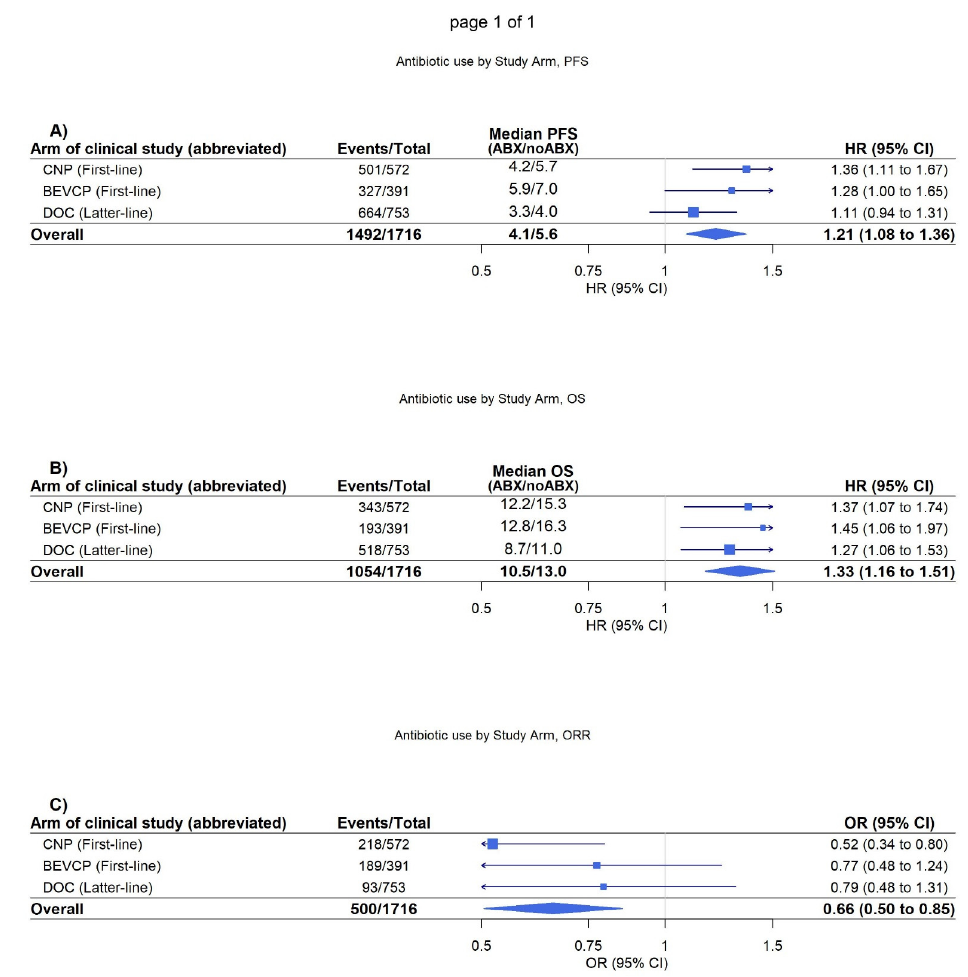
Figure 2. CNP (carboplatin and nab-paclitaxel), BEVCP (bevacizumab, carboplatin, and paclitaxel), and DOC (docetaxel). Forest plot of the adjusted association between antibiotic use and prognosis by study arm in the cohort randomised therapies without atezolizumab. Median time to progression-free survival (PFS) and overall survival (OS) are unadjusted. ( A ) Forest plot of association of antibiotics with PFS. ( B ) Forest plot of association of antibiotics with OS. ( C ) Forest plot of association of antibiotics with objective response rate (ORR).